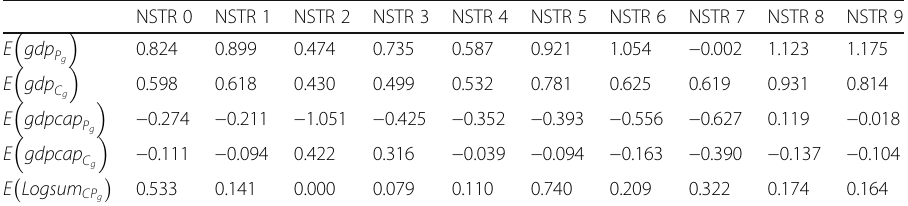
Table 5 Elasticities for the trade